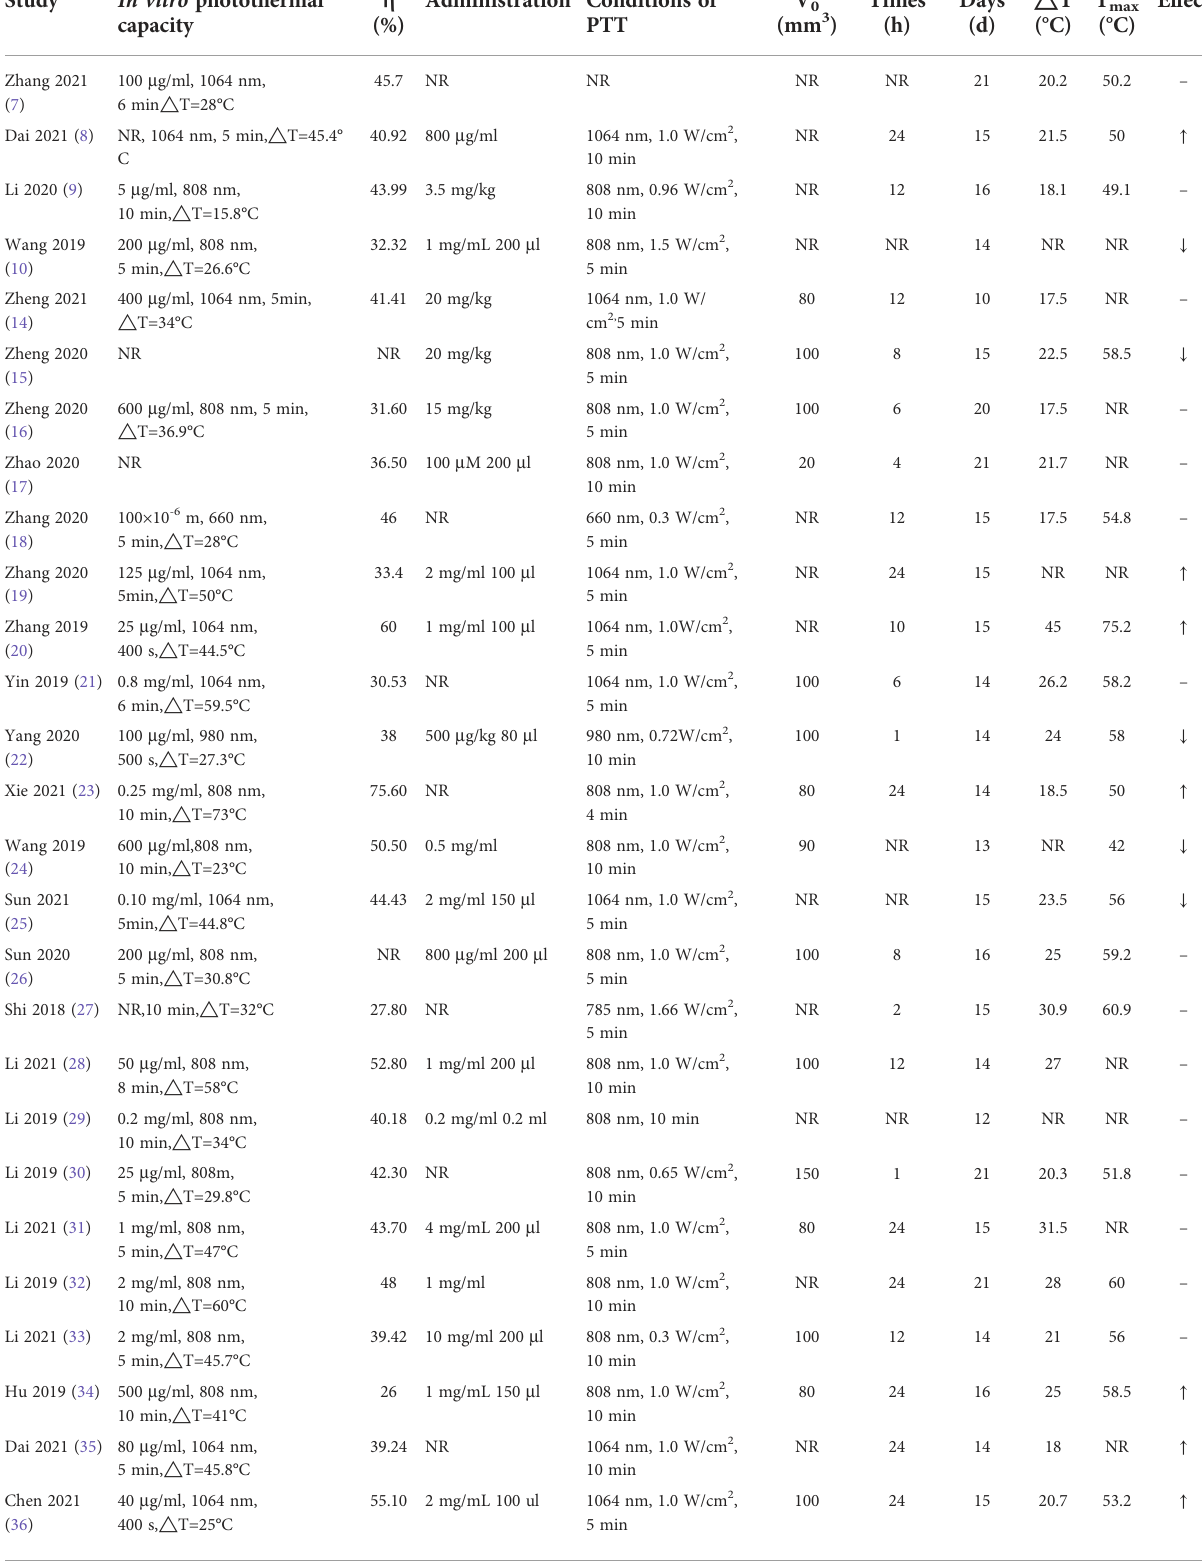
TABLE 3 The characteristic pro fi les of PTA for photothermal treatment. Study In vitro